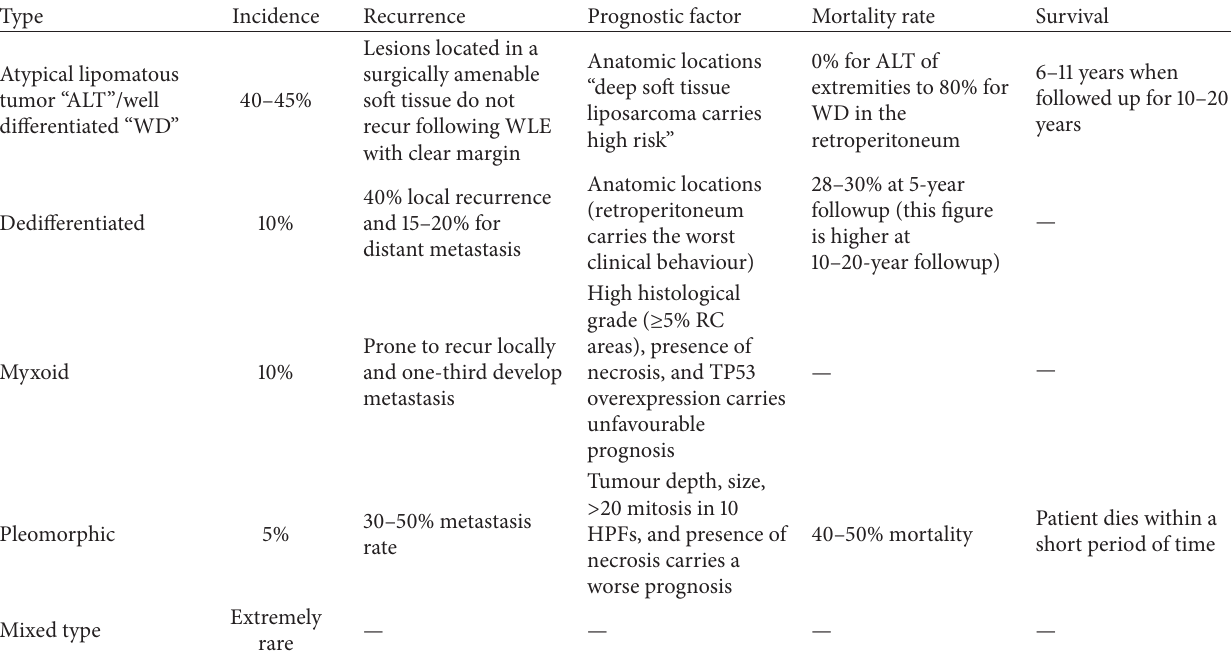
Table 1: Liposarcoma classification and characteristics according to the World Health Organisation classification of tumours